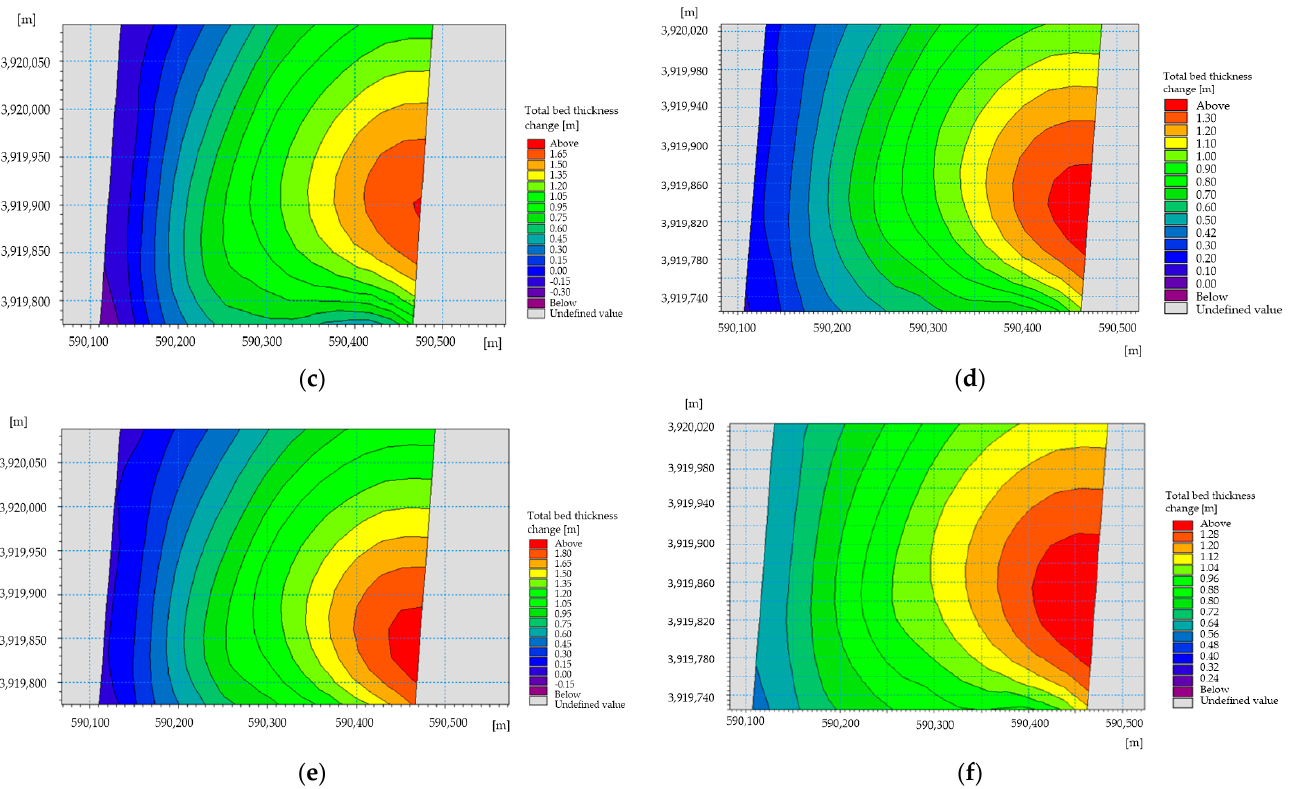
Figure 13. Distribution of local silting in flood and non-flood seasons, ( a ) is scheme I flood season, the coordinate range is (590,100, 3,919,800)~(590,500, 3,919,850), ( b ) is scheme I non-flood season, the coordinate range is (590,100, 3,919,740)~(590,500, 3,920,020), ( c ) is scheme II flood season, the coordinate range is (590,100, 3,919,800)~(590,500, 3,920,050), ( d ) is scheme II non-flood season, the coordinate range is (590,100, 3,919,740)~(590,600, 3,920,020), ( e ) is scheme III flood season, the coordinate range is (590,100, 3,919,800)~(590,500, 3,920,050), ( f ) is scheme III non-flood season, the coordinate range is (590,100, 3,919,740)~(590,500, 3,920,020). The total bed thickness is negative, which represents the scouring in the sedimentation basin.